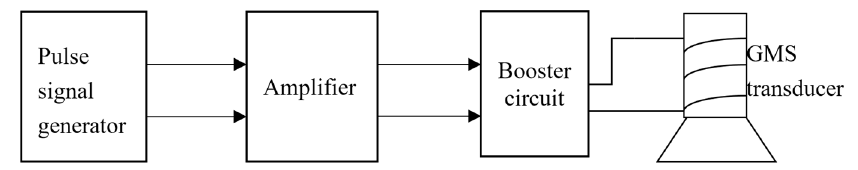
Figure 3. The pulse driving circuit for the GMS transducer.